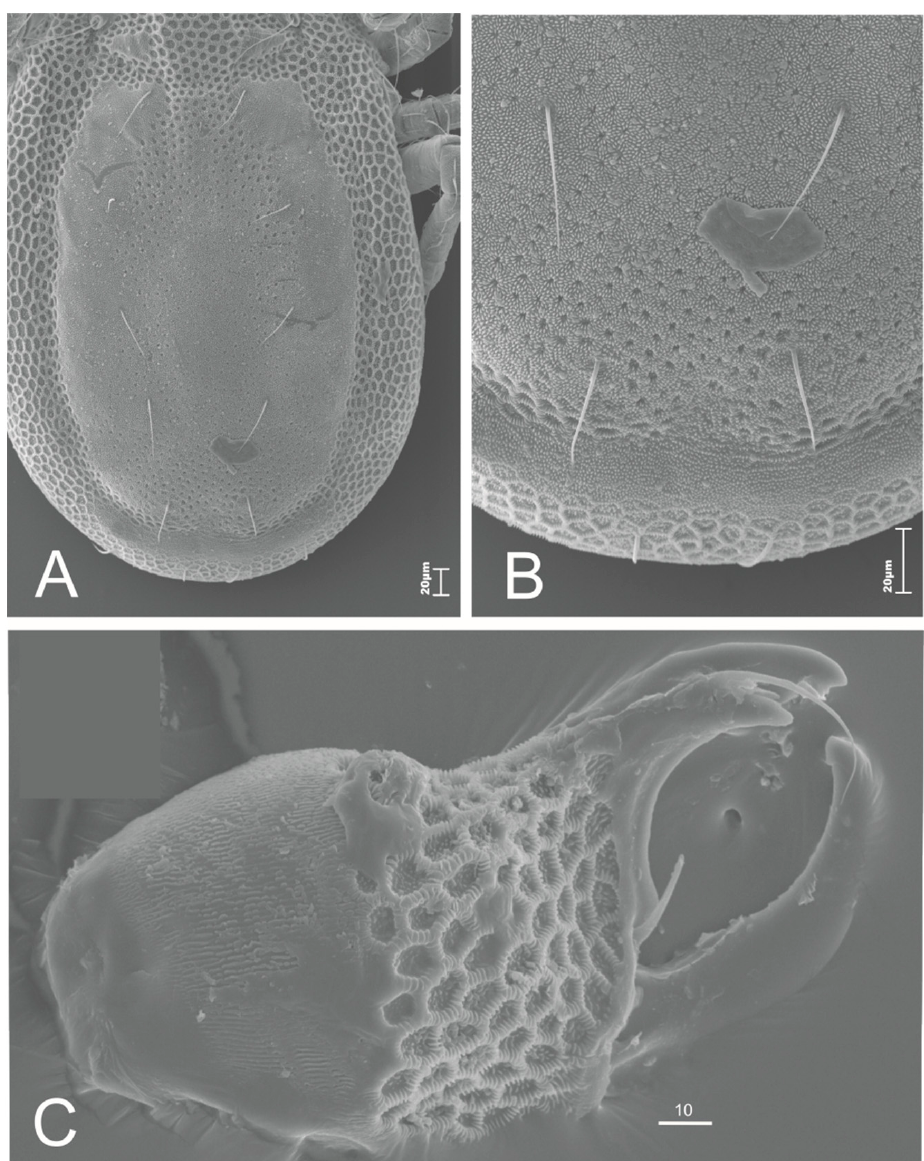
Figure 2. Male of L. luteum : ( A )—central part and rear part of idiosoma with two different types of body surface sculpture; ( B )—non-polygonal body surface sculpture (ultra-high resolution); ( C )—chelicerae. SEM observations.